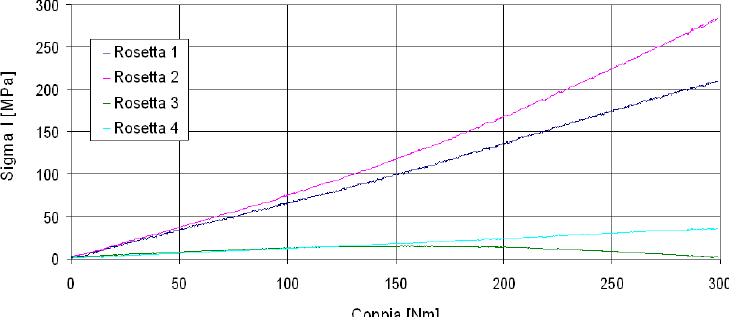
Figura 15: Andamento dello sforzo principale σ I ricavato sulla base dei dati estensimetrici durante la prova statica.